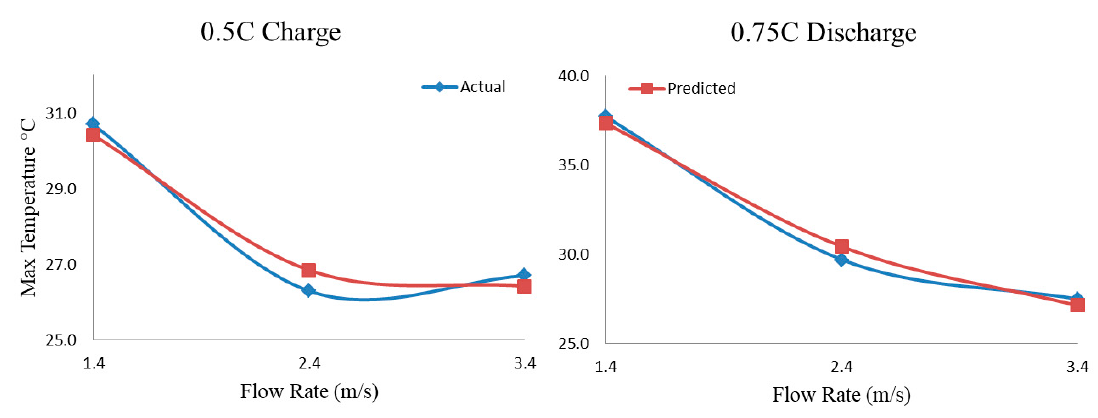
Figure 26. Regression model predicted output vs. actual output for a sample input. Figure 26 . Regression model predicted output vs. actual output for a sample input.